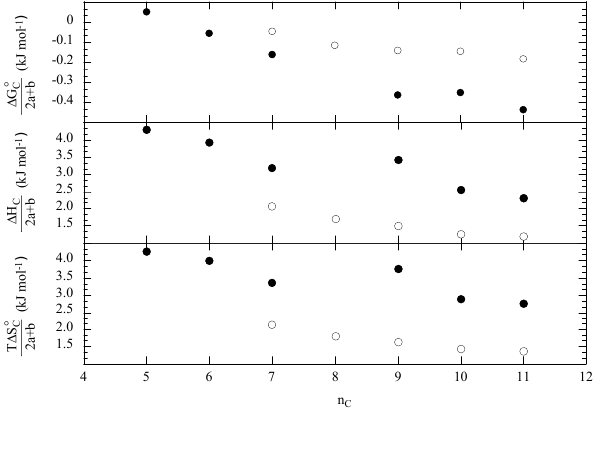
Figure 12. Standard free energy, enthalpy and entropy for the formation of copolymer+surfactant pre-micellar aggregates, normalized for (2a+b), as functions of the number of carbon atoms in the sodium alkanoates alkyl chain at 298 K. ● , L64; ○ , F68. Data are from Ref.